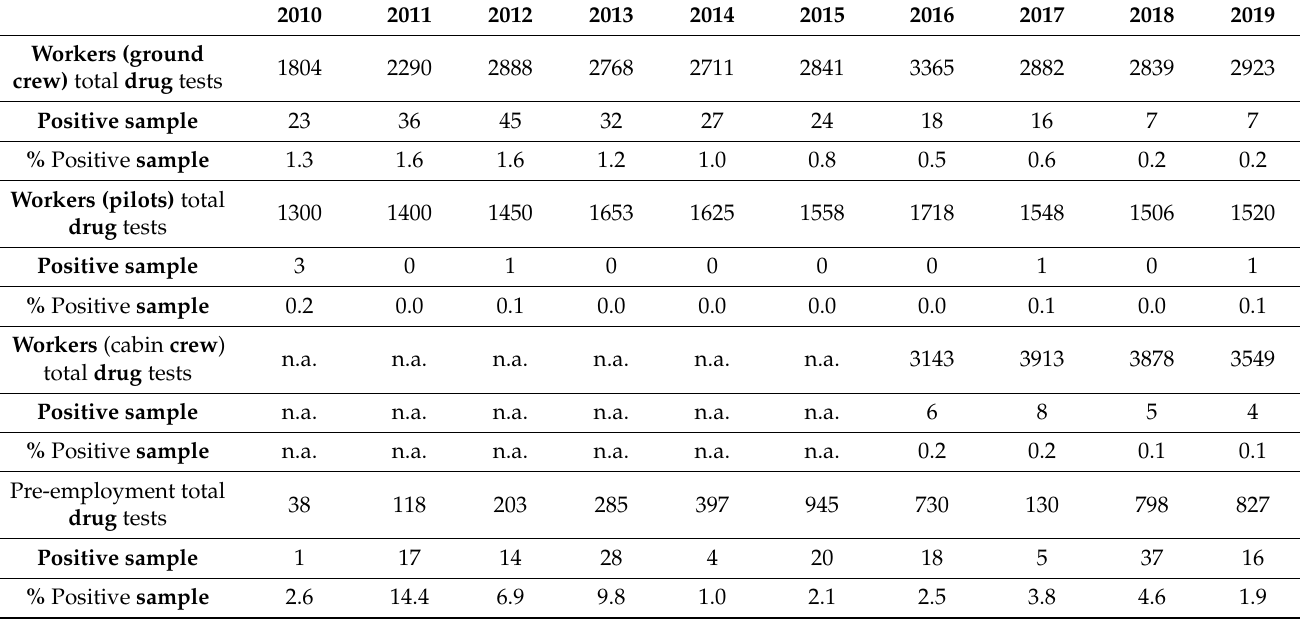
Table 4. Rapid test and confirmatory test positive samples. As shown in the table, out of 614 positive